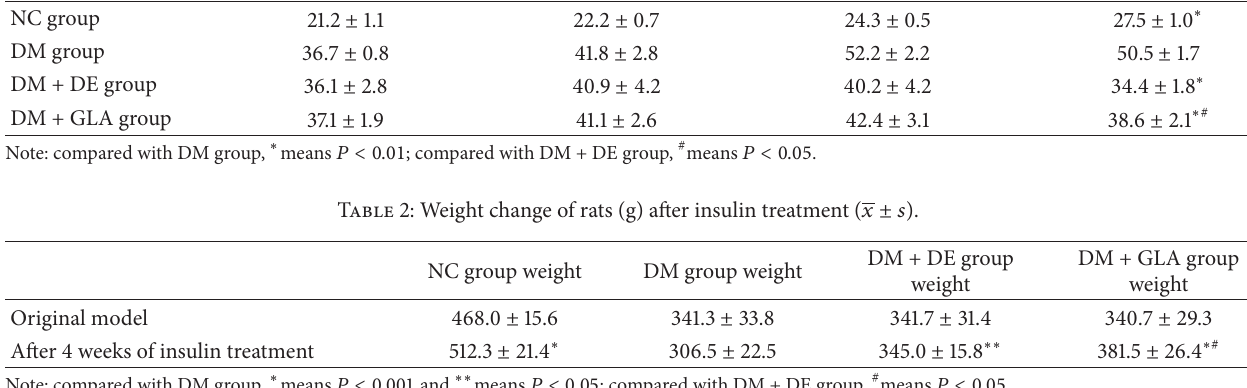
Table 1: Changes in food intake (g/day/rat) during insulin treatment ( 𝑥 ± 𝑠 ). Groups